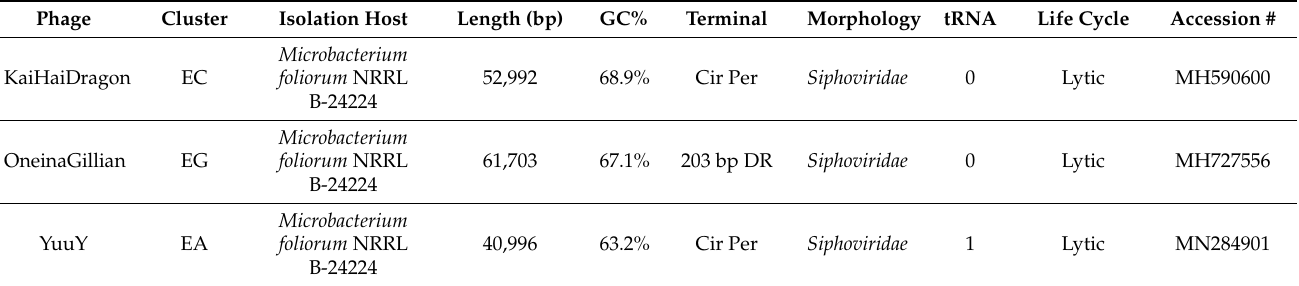
Table 2. Genometrics of Microbacterium